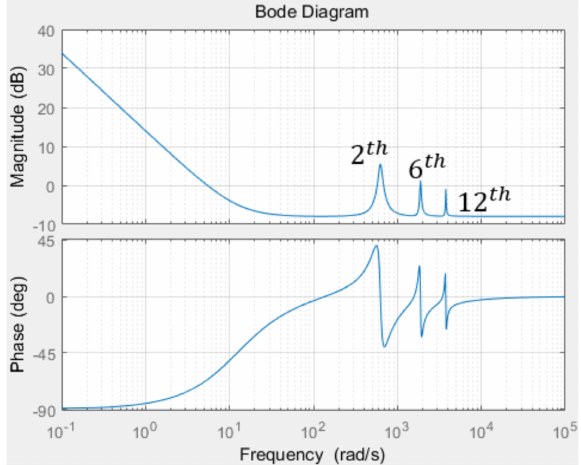
Figure 18. Bode plot of PI + MR